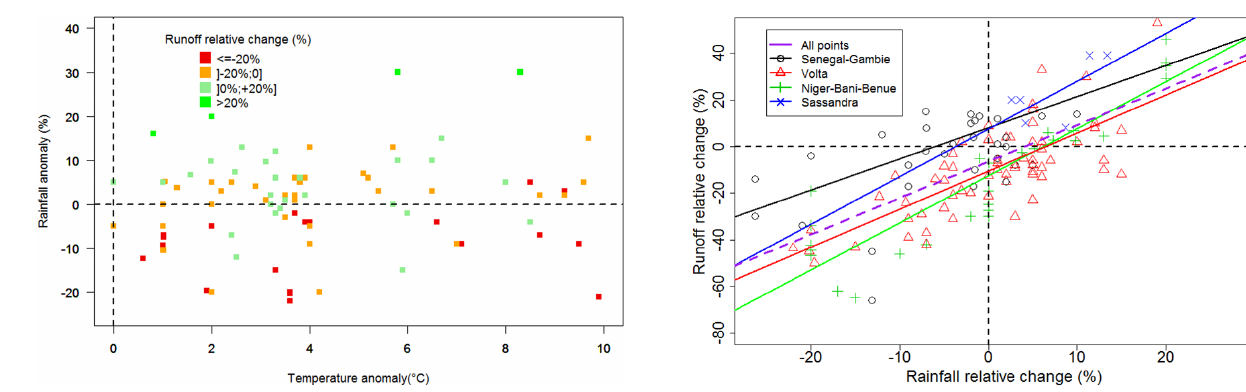
Figure 6. Relationship between runoff change ( y axis, %) and rain- fall relative change ( x axis, %) for the four main rivers and for the whole panel (purple dashes). The lines represent the linear model for each river. Note that we put Senegal and Gambia